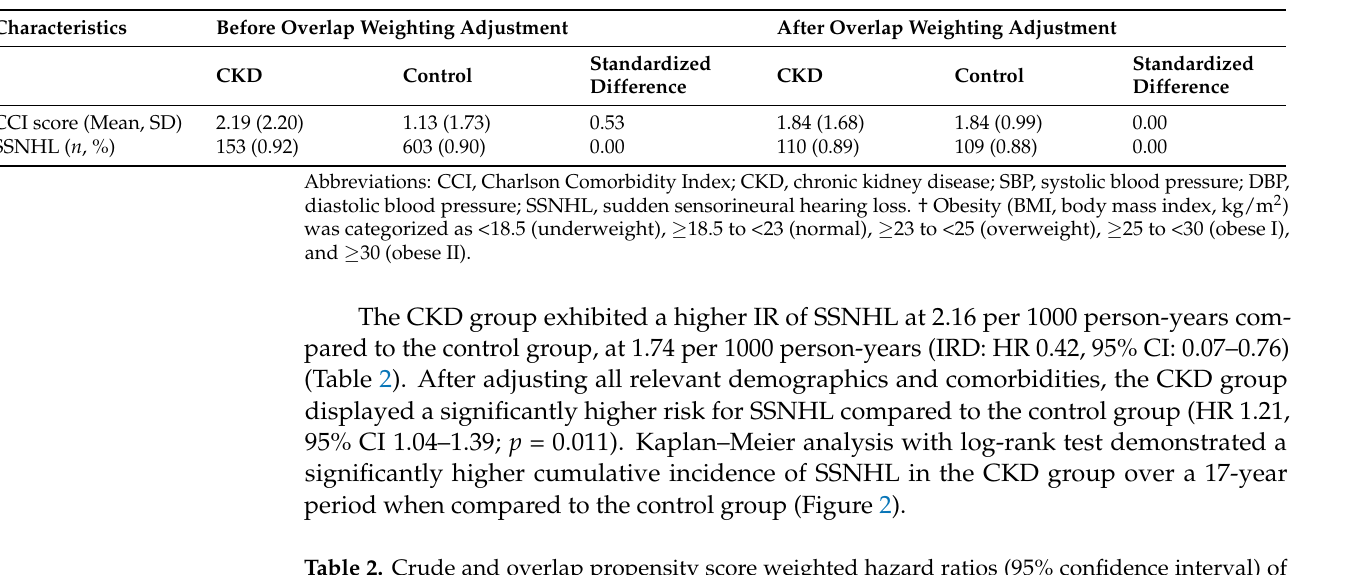
Table 2. Crude and overlap propensity score weighted hazard ratios (95% confidence interval)